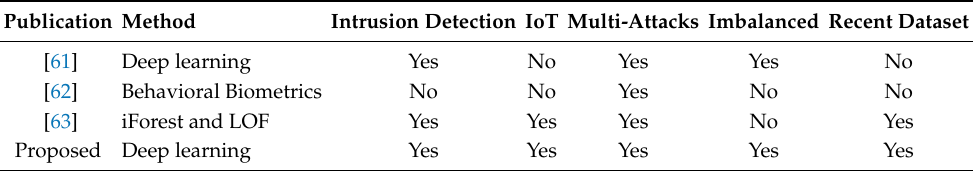
Table 1. A comparison between the proposed approach and other methods in the